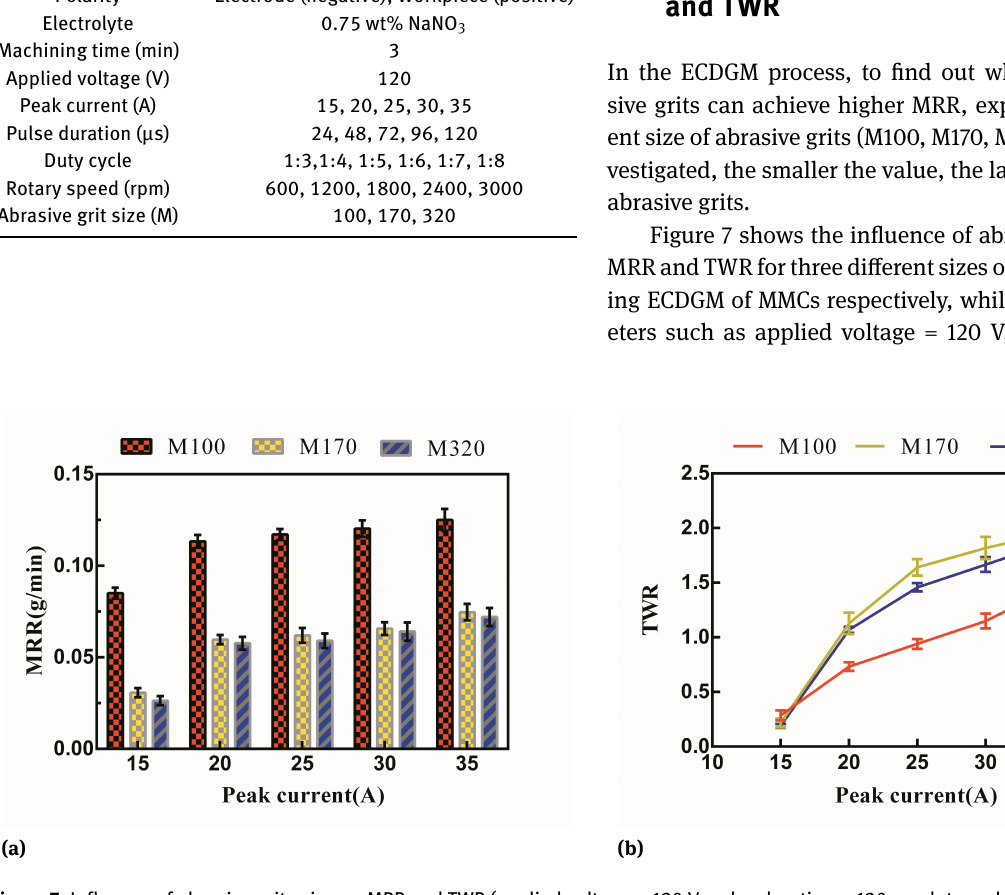
Figure 7: Influence of abrasive grits size on MRR and TWR (applied voltage = 120 V, pulse duration = 120 µ s, duty cycle = 1:5, rotary speed = 2400